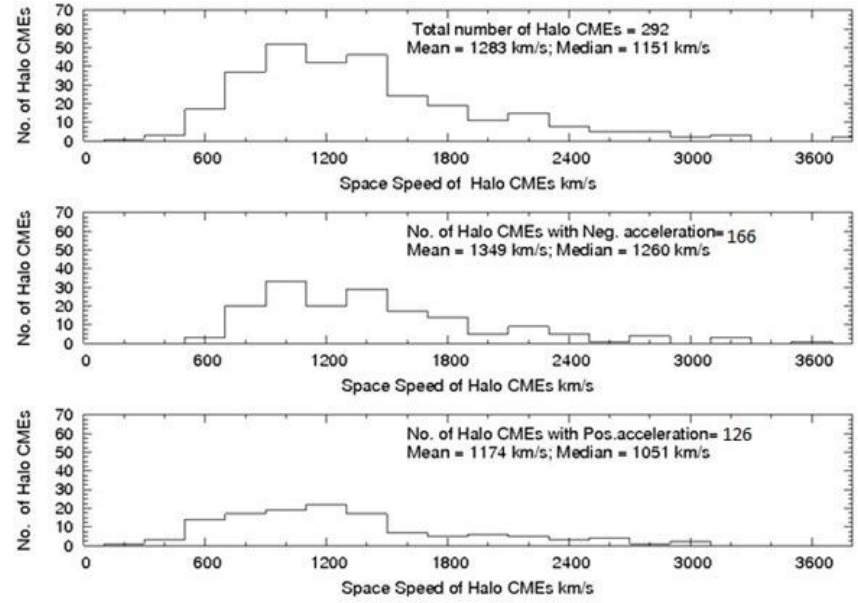
Figure 3. The upper part of the figure shows a plot of the space speed of HCMEs versus a number of the HCMEs, the middle part of the figure shows a plot of the space speed of HCMEs versus a number of the decelerate halo CMEs and the lower part of the figure shows a plot of the space speed of HCMEs versus a number of the accelerated HCMEs.